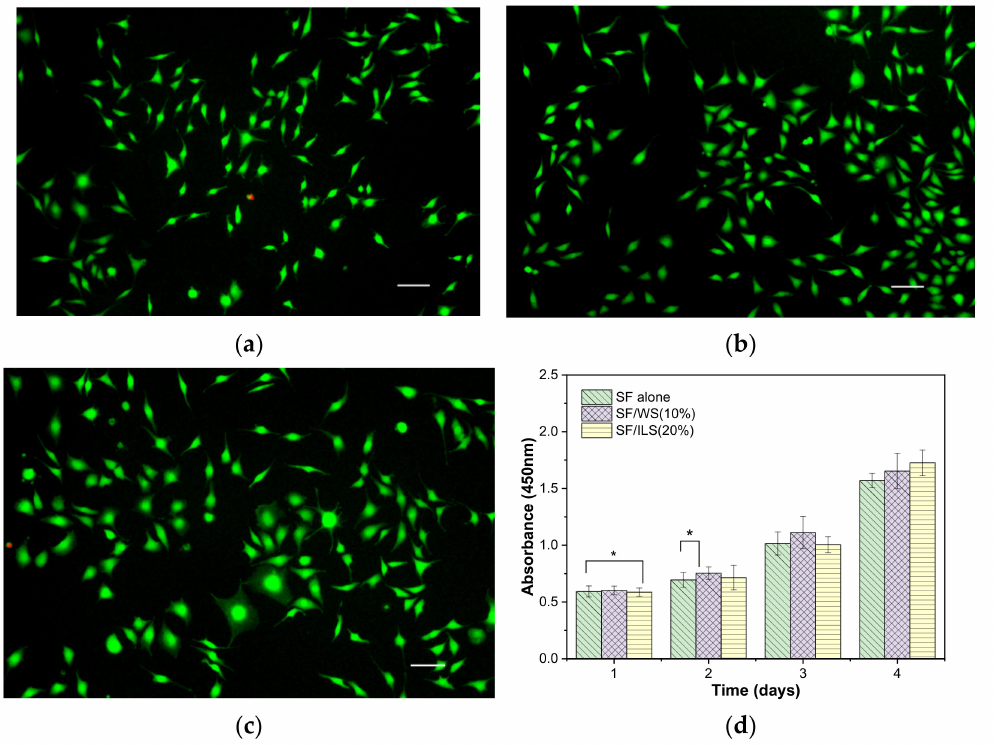
Figure 12. The proliferation of mouse fibroblast L-929 on the SP scaffolds. Microscopic fluorescence photographs (200 × ) of L-929 cells on day 4 of the three SP scaffolds: SF alone ( a ); SF/WS (10%) ( b ); SF/ILS (20%) ( c ); and their proliferation curves on days 1 to 4 ( d ). All scales are 200 µ m; * represents p < 0.05; the difference was